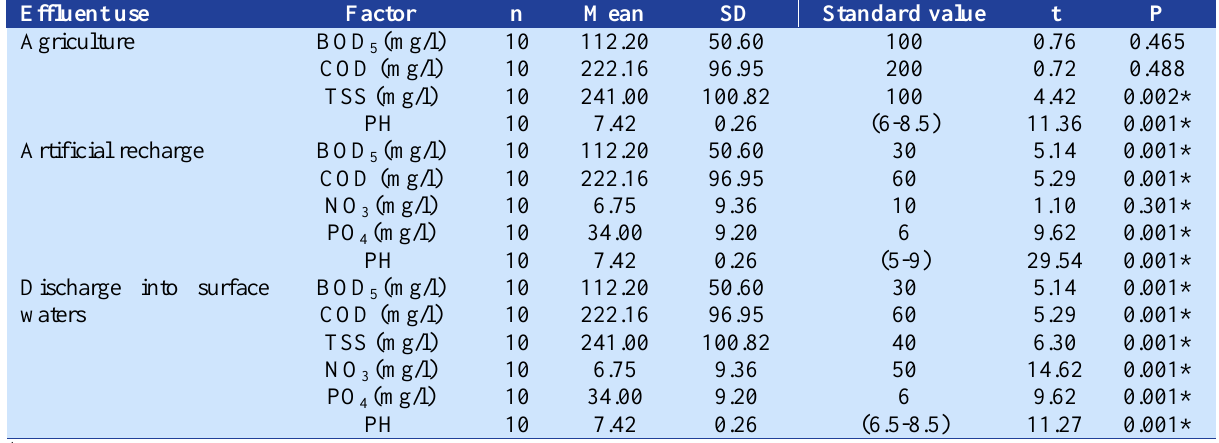
Table 3. Comparison of average wastewater quality parameters of Pelareh Dairy Industry effluent wastewater and Iranian Department of Environment